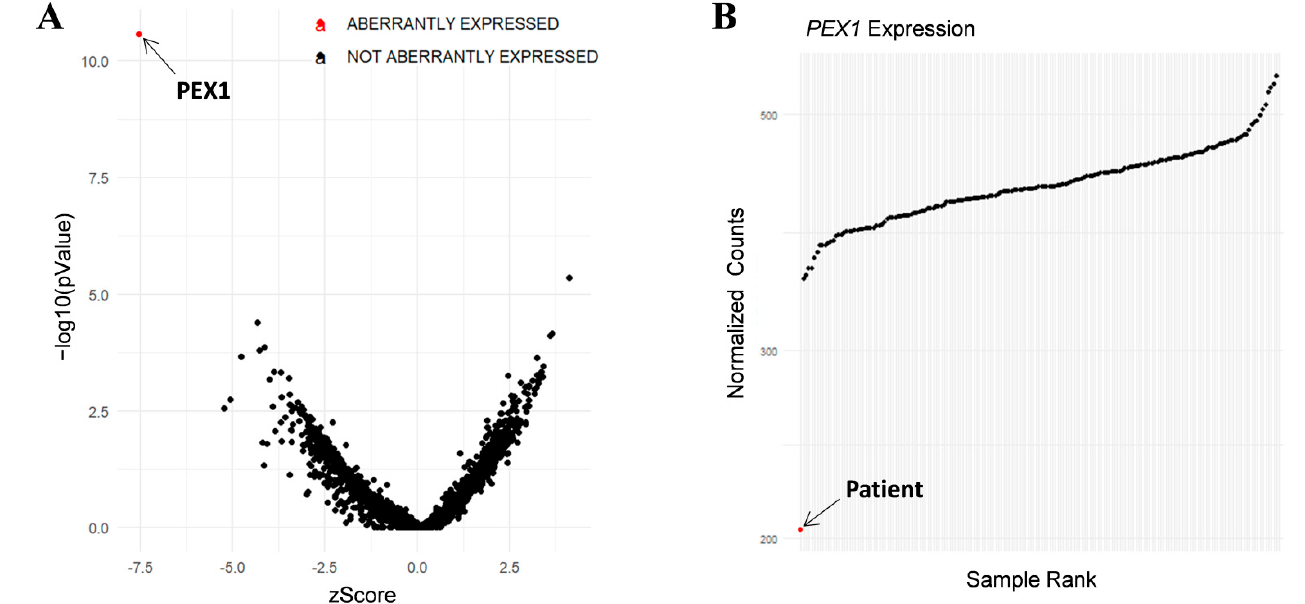
Figure 1. RNA-seq analysis in patient’s fibroblasts. ( A ) RNA expression volcano plot showing gene level significance ( − log10 p value) against Z-scores. Red dot highlights PEX1 as the most aberrantly expressed gene in this patient. ( B ) Expression Rank plot indicates (red dot) that the levels of PEX1 mRNA levels detected in our patient were the lowest among the entire cohort of transcriptomes